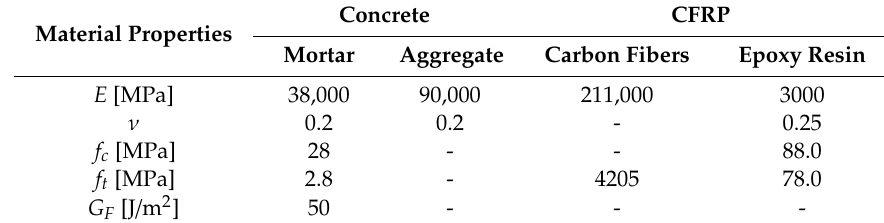
Table 1. Mechanical properties of concrete and Carbon Fibre Reinforced Polymer (CFRP).